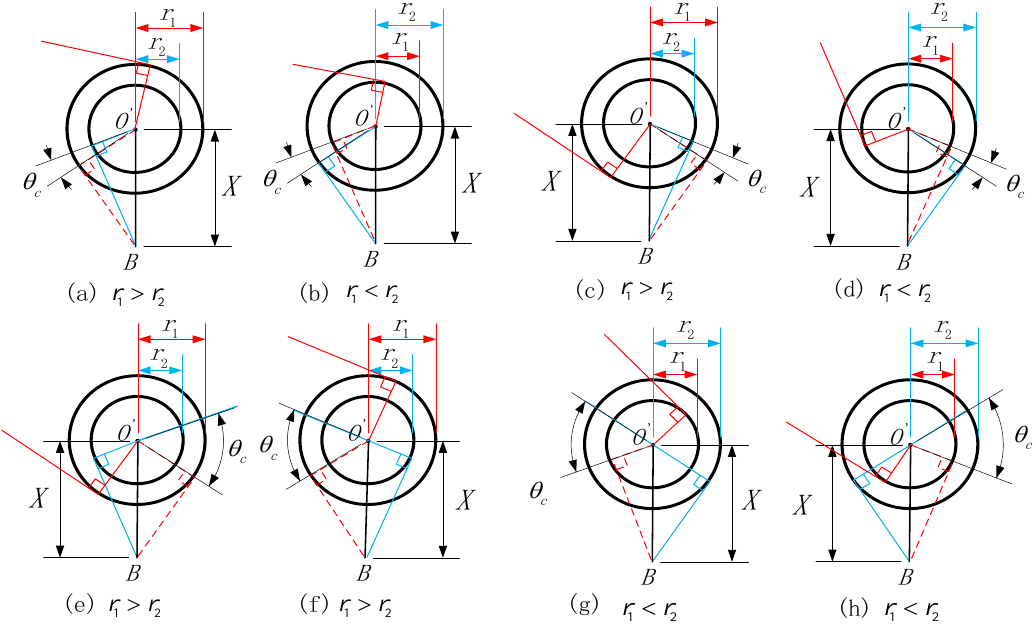
Figure 5. Different status of the calibration of 𝜃 𝑐 .